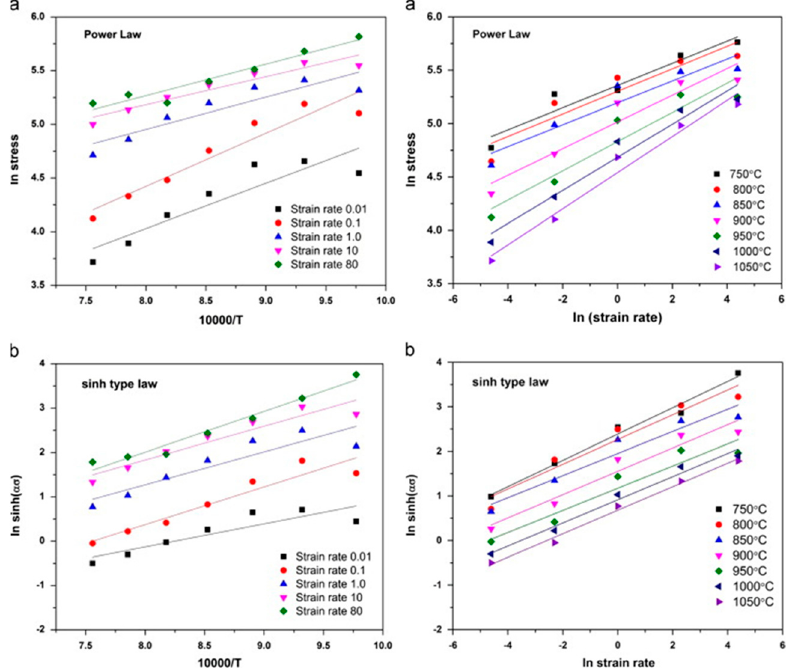
Figure 13. Flow stress and temperature plots for all strain rates at the true strain of 0.6 using ( a ) power law and ( b ) sinh type law [82] . law and ( b ) sinh type law